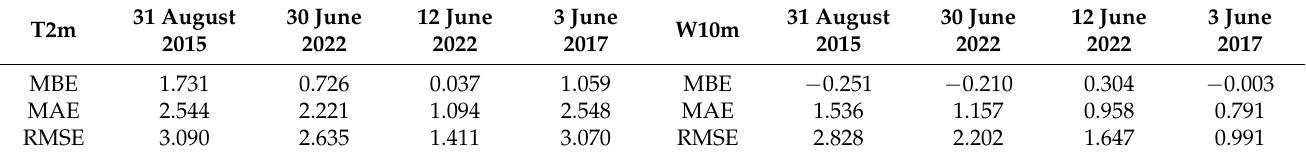
Figure 5. Comparison of predicted (WRF) and observed (SYNOP) 10 m wind speed at the airport.